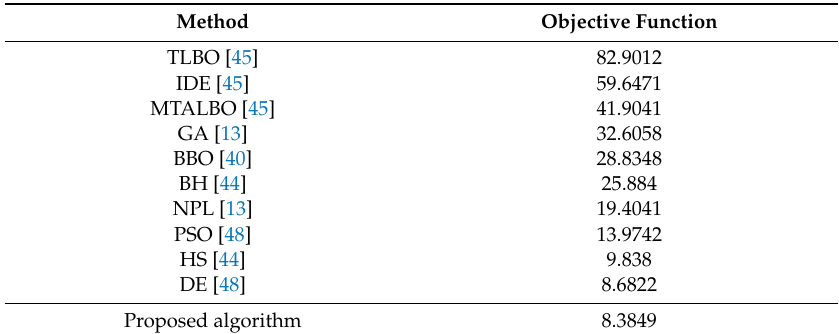
Table 10. Comparison of the WOA result with the methods used in the literature for the IEEE-9 bus system.